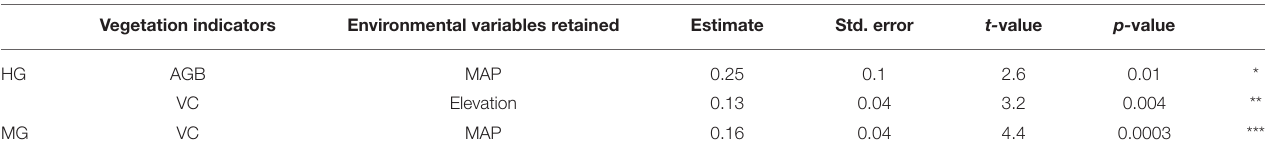
TABLE 3 | Minimum adequate linear models for environmental interactions with relative grazing effects (heavy and moderate grazing) on AGB ( N = 28), SR ( N = 30), and VC ( N = 21).